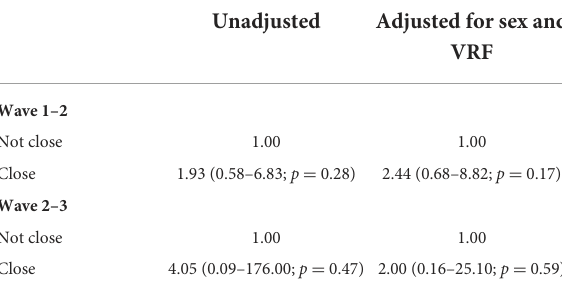
TABLE 3 Association between proximity of deep WMH to PVS and deep WMH progression by binary logistic regression with random